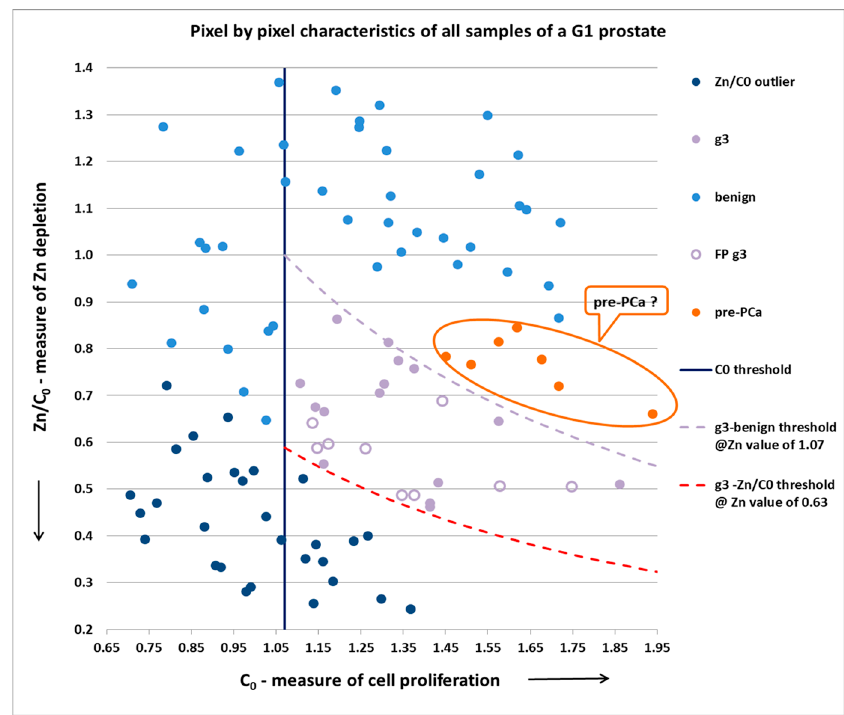
Figure 4. Pixel characteristics and thresholds in a low-PCa-malignancy-score G1 Prostate (9 samples out of 16 were g6(3 + 3), the remainder being only g3 and benign pixels). The positive pixels—g3, in this case—had a C 0 (x-axis) threshold level = 1.07 (for this specific prostate), and had values of C 0 and Zn/C 0 (y-axis) bound between the two Zn threshold lines for this specific prostate, with a lower threshold between g3 and outlier low pixels corresponding to a Zn value of 0.63, and an upper threshold between g3 and benign pixels corresponding to a Zn value of 1.07. The same logic applies to the high-PCa-malignancy-score (G4) prostate below.